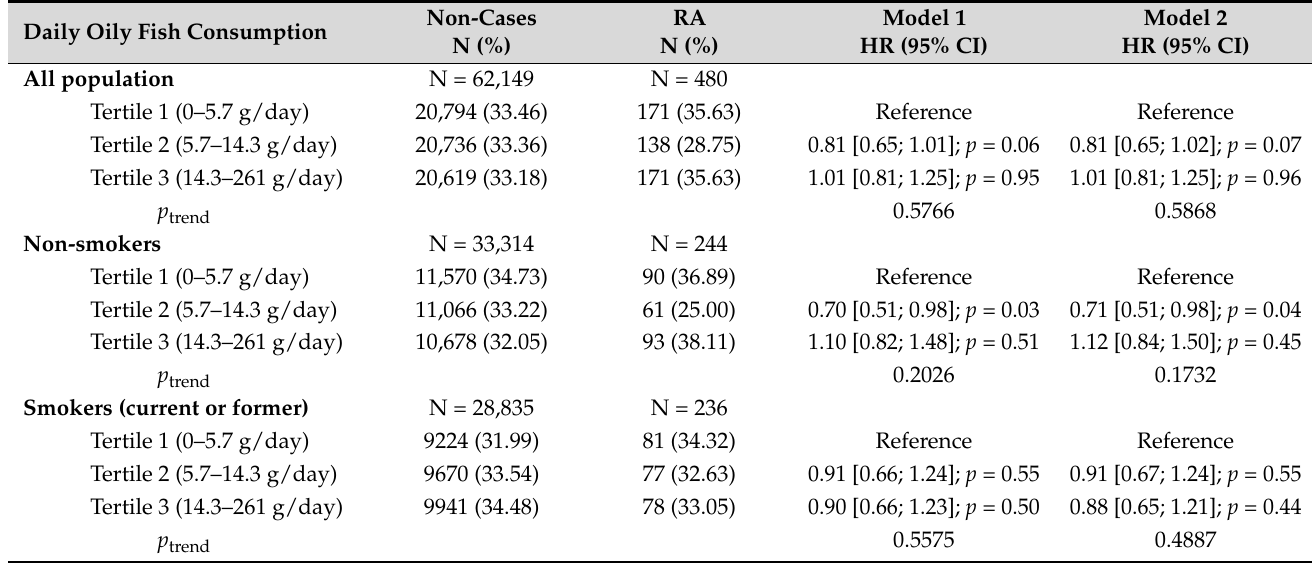
Table 4. Hazard ratios (95% confidence intervals) for the risk of rheumatoid arthritis (RA) by tertiles of oily fish consumption including sardine, mackerel, salmon, trout, and/or tuna (N =